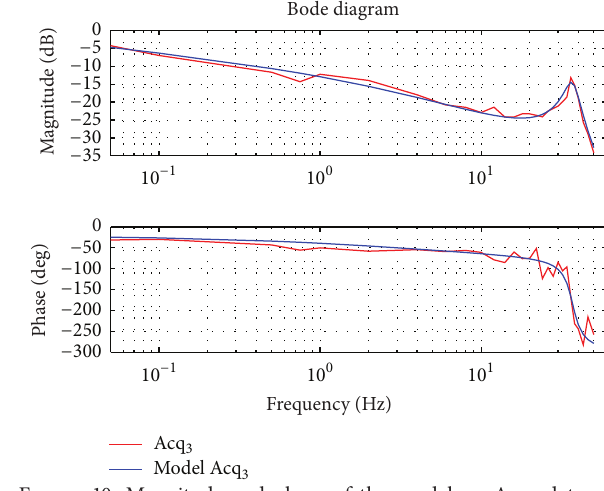
Figure 7: Magnitude and phase of the mean model on Acq 1 , Acq 2 , and Acq 3 via GAs.